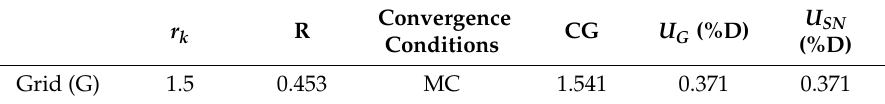
Table 12. The numerical uncertainties of the grid spacing under the